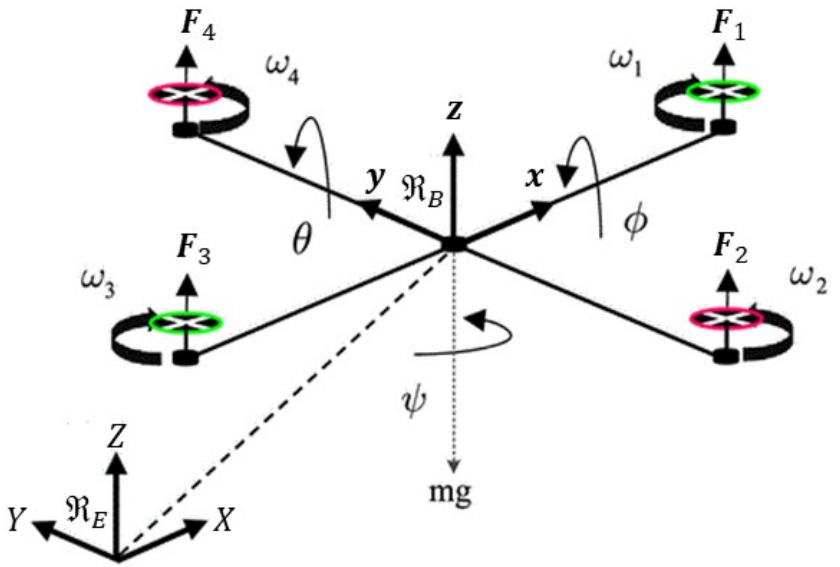
Figure 1. The coordinate frame of the quadcopter.